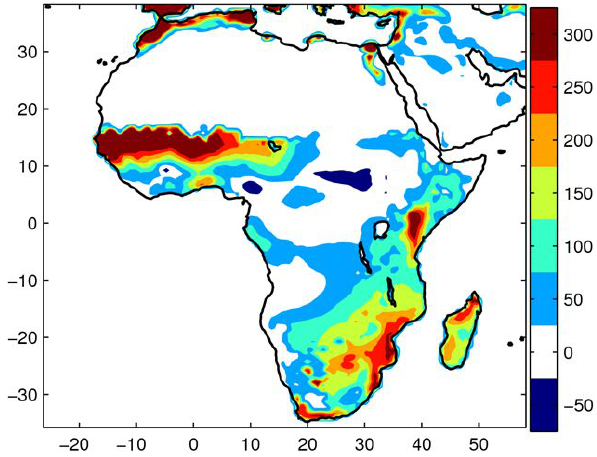
Fig. 9. Mean annual soil moisture increments (in mmyr − 1 ) in ERAI resulting from the soil moisture assimilation